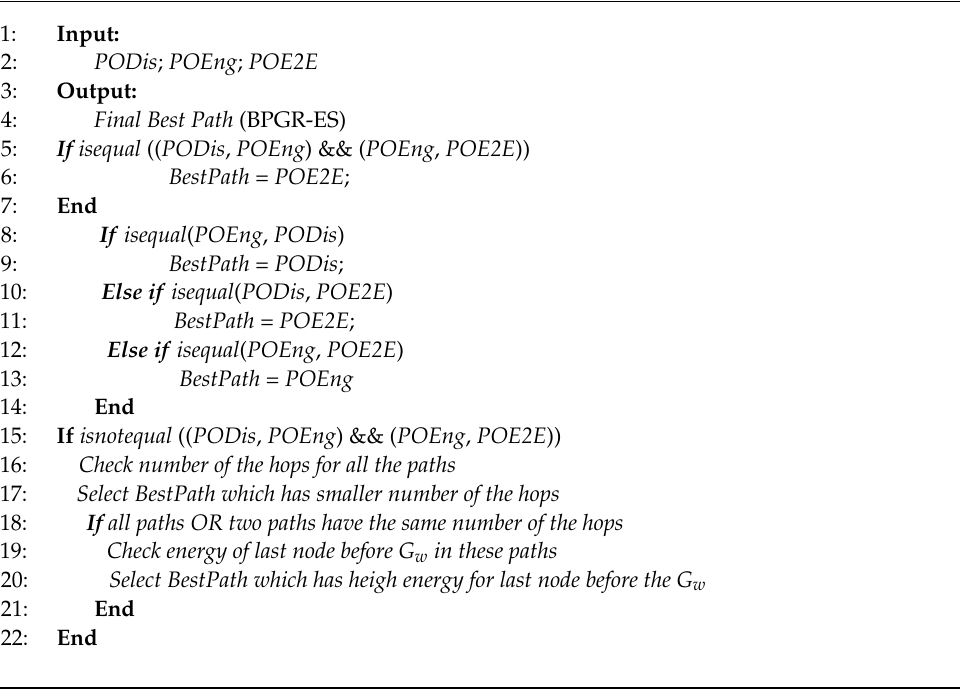
Algorithm 3: Selection Best Path of Graph Routing